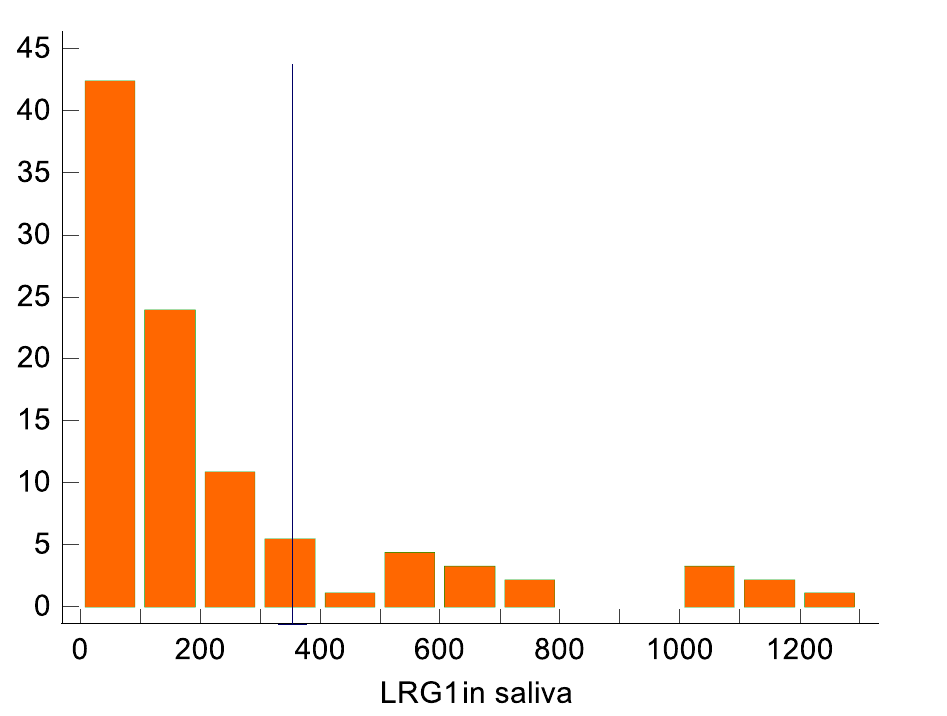
Figure 2. LRG1 distribution in saliva, with the marked cutoff of >352.6 ng/mL identified as optimal for distinguishing between appendicitis and non-appendicitis. Appendicitis was diagnosed in all 17 participants with >352.6 ng/mL.